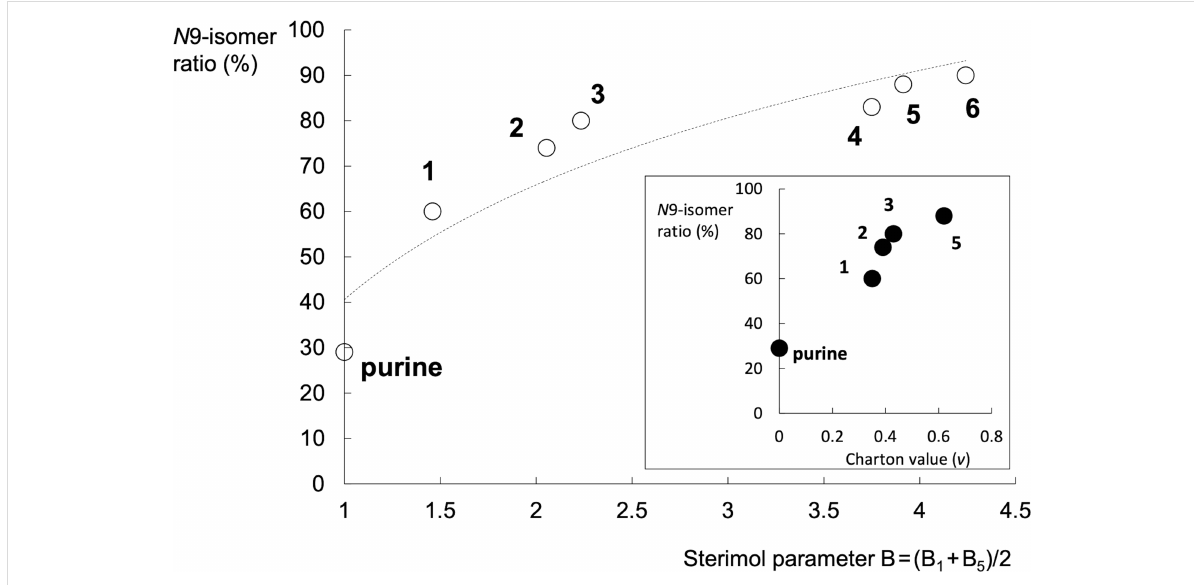
Figure 3: Dependence of N 9-isomer product ratio (%), in the reaction between FcCOCl and adenine anions 1 – 6 , on the averaged perpendicular Ster- imol parameter B = (B 1 + B 5 )/2 of the C 6-substituent (open circles; in the parent purine the C 6-substituent is a H atom). The logarithmic trendline is for illustration purposes only. The inset shows the dependence of N 9-isomer ratio (%) on the Charton value (closed circles; ν is not available for all C 6-substituents). Purine (B = 1; ν = 0) is the anion derived from the parent 9 H -purine structure.